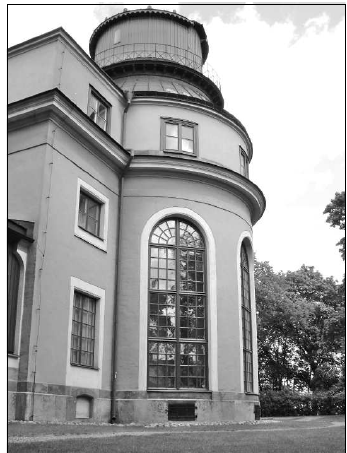
Fig. 1. The observatory building in Stockholm at south with the dome at top. Image: Michael Lindberg.